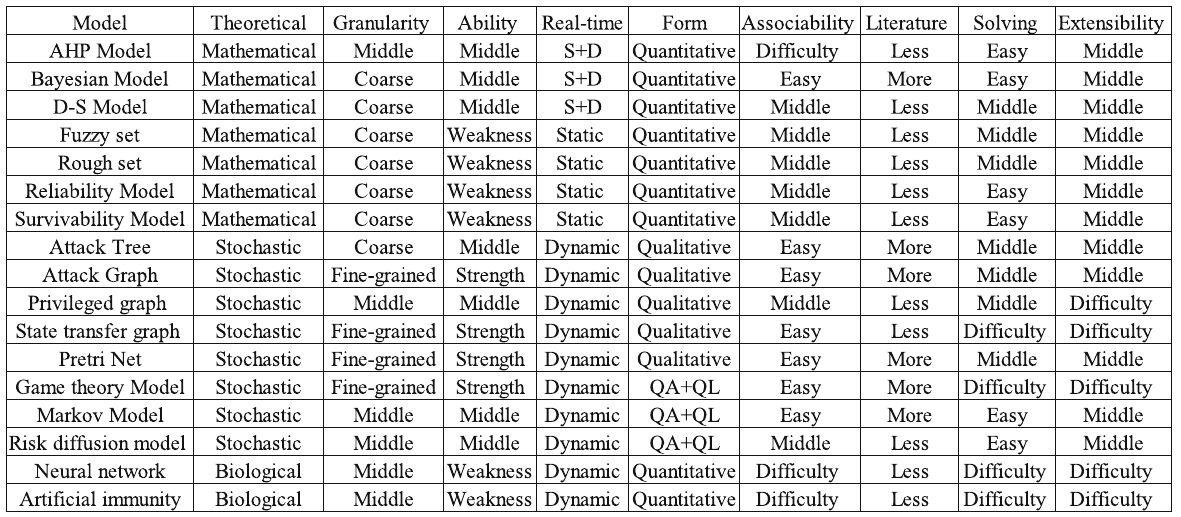
Table 8 Comparison results of each